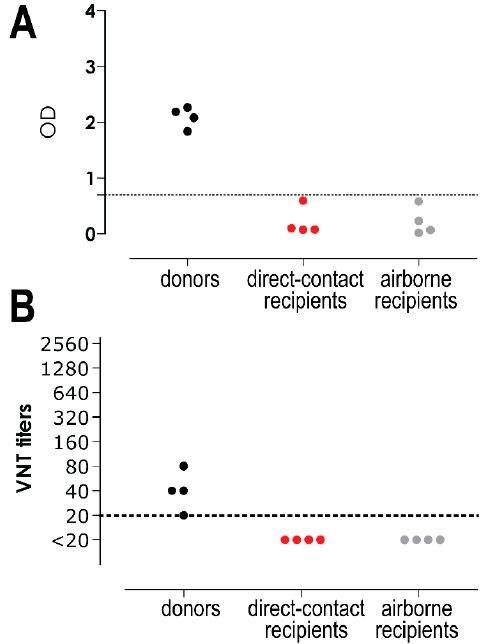
Figure 5. Shedding of Middle East respiratory syndrome coronavirus (MERS-CoV) RNA and infectious virus in directly inoculated, contact-exposed and airborne-exposed rabbits. MERS-CoV RNA and infectious virus were measured in the nasal ( A , B ) and throat swabs ( C , D ). The amount of viral RNA is displayed in genome equivalents per mL (GE/mL), while infectious virus is shown as 50% tissue culture infective dose per ml (TCID 50 /mL). Dashed lines depict the detection limit of each assay.